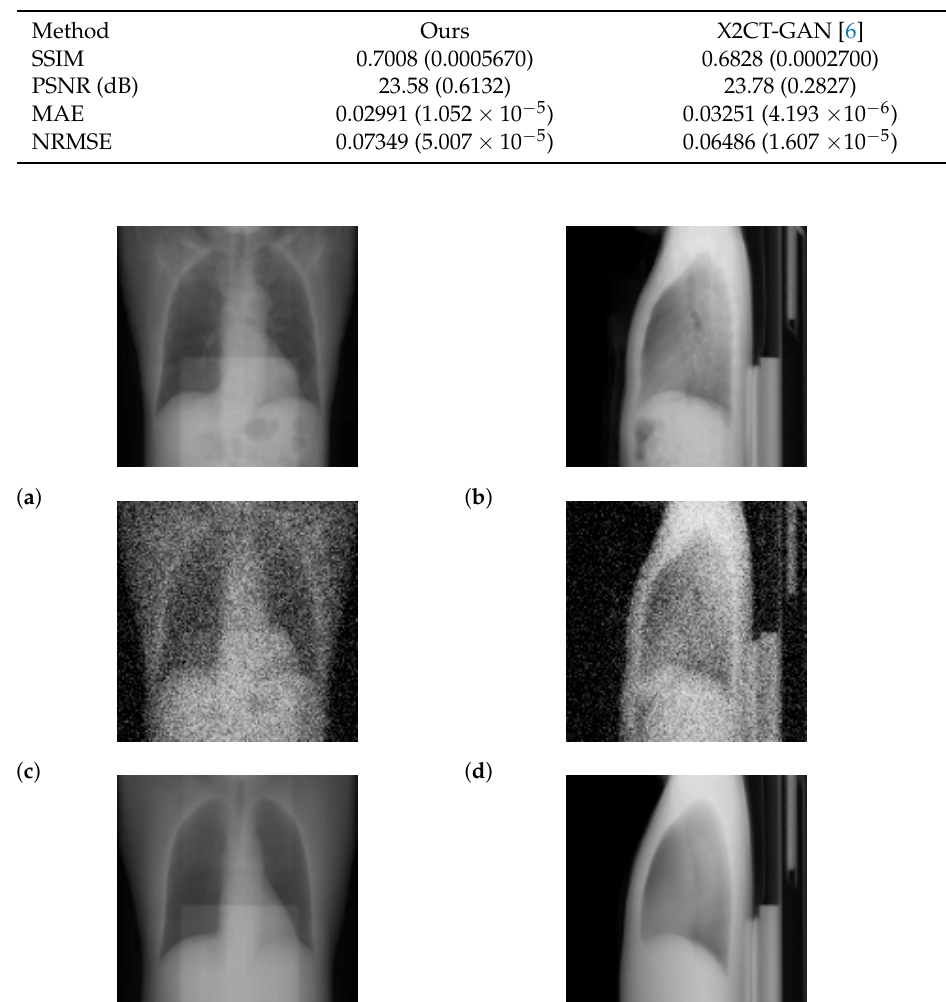
Table 5. Means of metrics ( N = 2, ultra-low-dose protocol). We show variances in brackets.